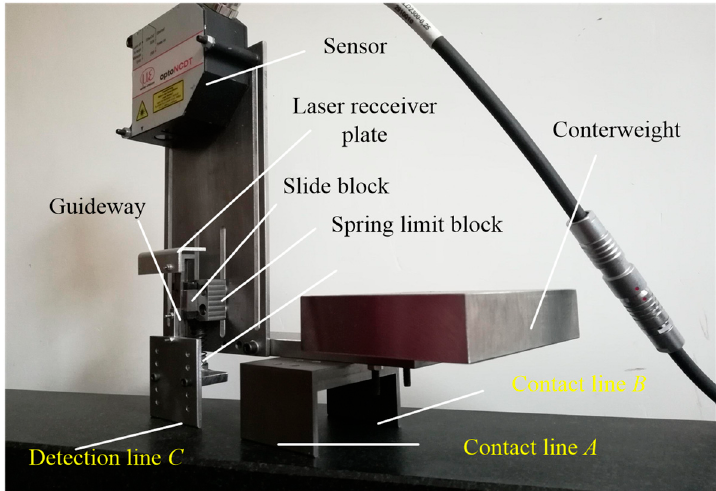
Figure 2. Measurement mechanism for measuring two horizontal parallel surfaces.